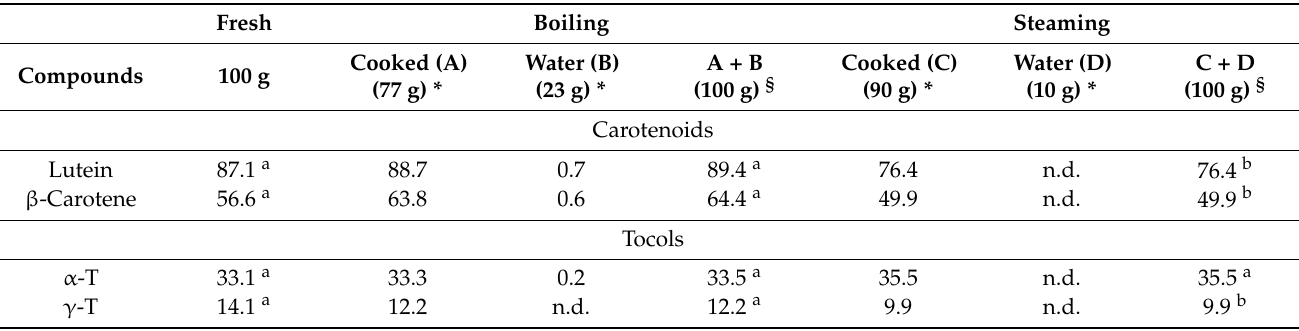
Table 6. Content of the main carotenoids and tocols in fresh vegetables (mg/100 g d.m.), in cooked samples (mg/g d.m.) and in cooking water (mg/g d.m.) of C.